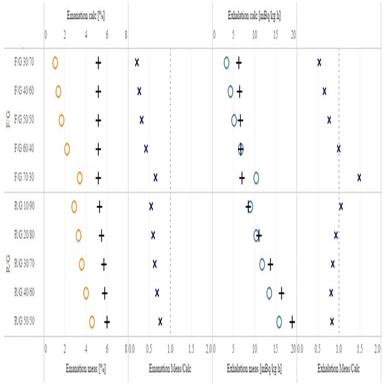
The measured (marked with circles) and calculated (marked with +) emanation and exhalation values and their ratios (marked with ×) in the case of fly ash and ground granulated blast furnace slag (F/G) and red mud and ground granulated blast furnace slag (R/G) series.